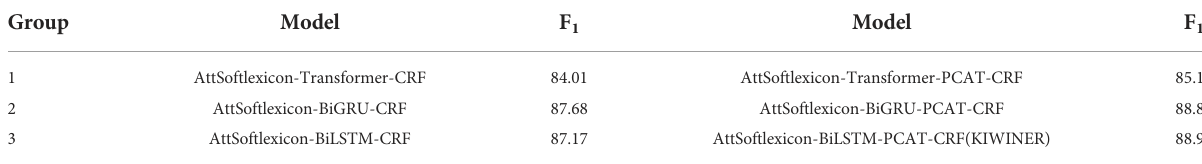
TABLE 6 Application effect of PCAT.